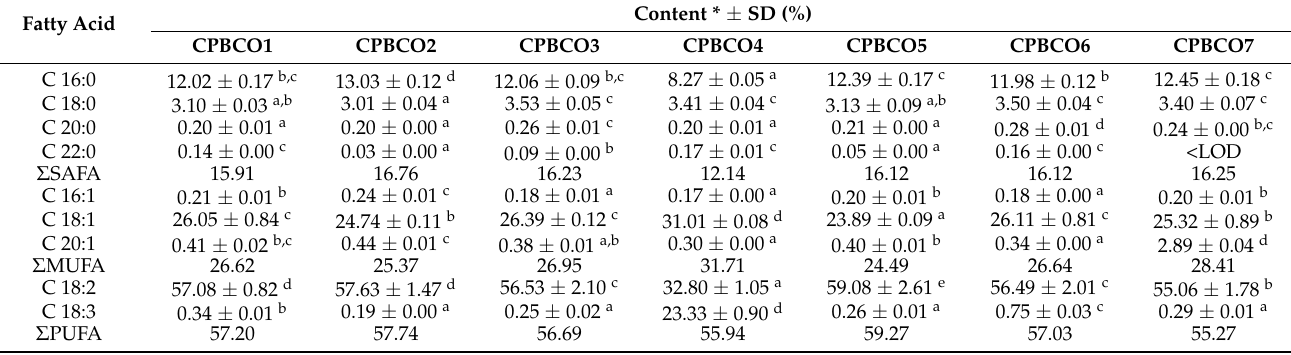
Table 6. Fatty acid compositions of cold-pressed black cumin